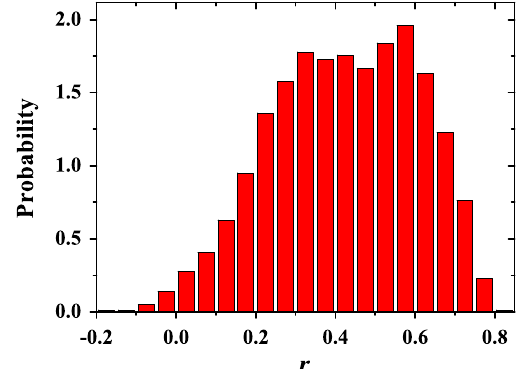
.FIG. 9. Distribution of the correlation coefficient r for the solid- liquid interfaces of the melted θ ¼ 28 ° grain boundary at ϕ ¼ 0 . 559